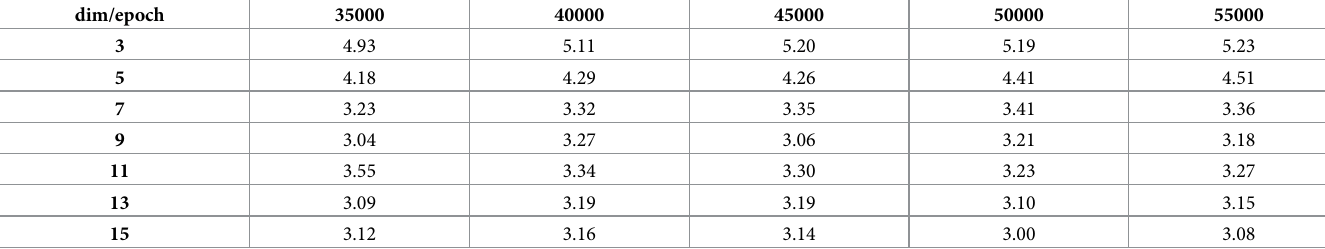
Table 2. Mean detector error (mm) of VAE over 9 test data. This is obtained by varying the number of epochs and latent space dimension.